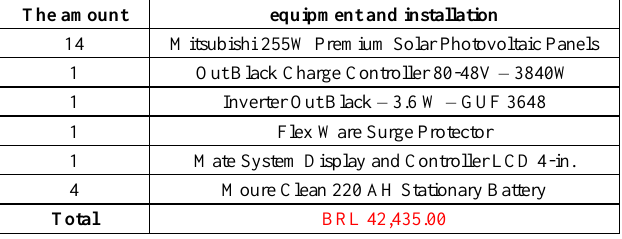
Table 5: Cost of equipment without installation price.